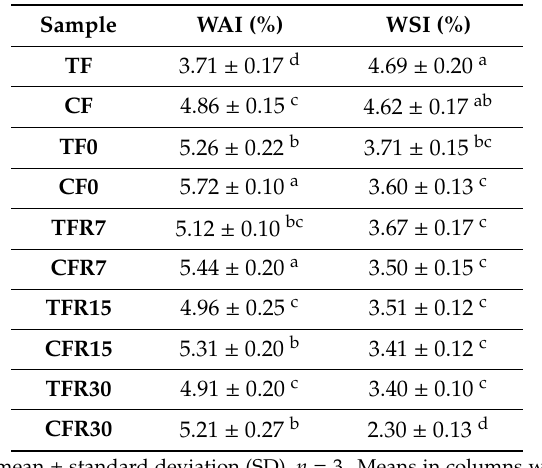
Table 4. Water absorption index (WAI) and water solubility index (WSI) of nixtamalized corn flours and corn tortilla flours obtained by the traditional and industrial